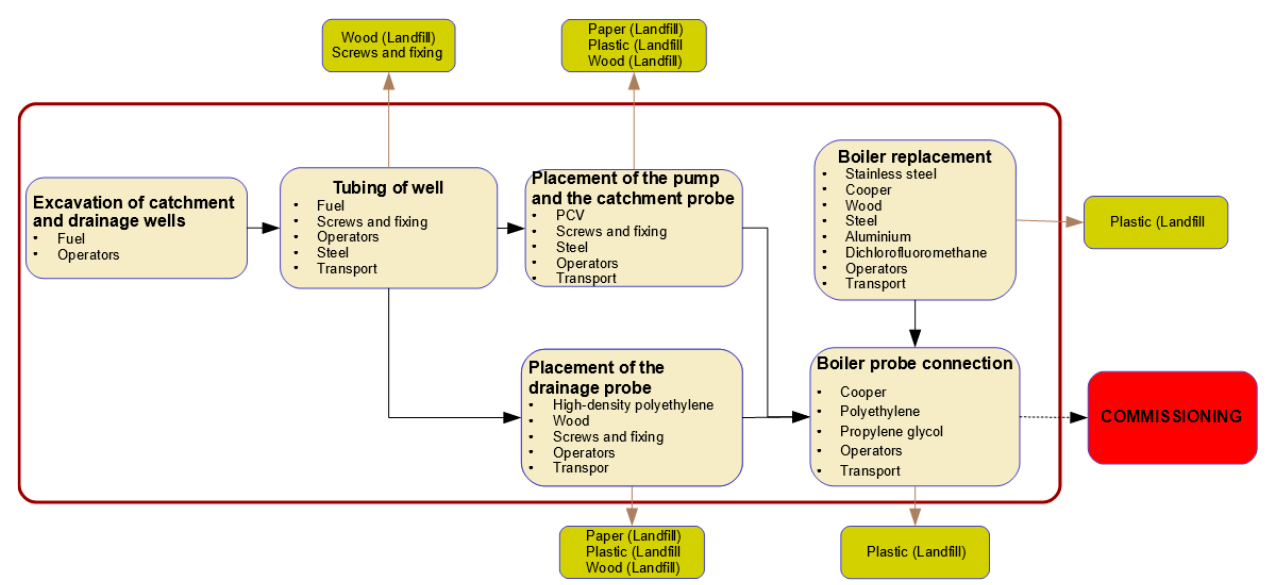
Figure 4. System boundaries for alternative C.